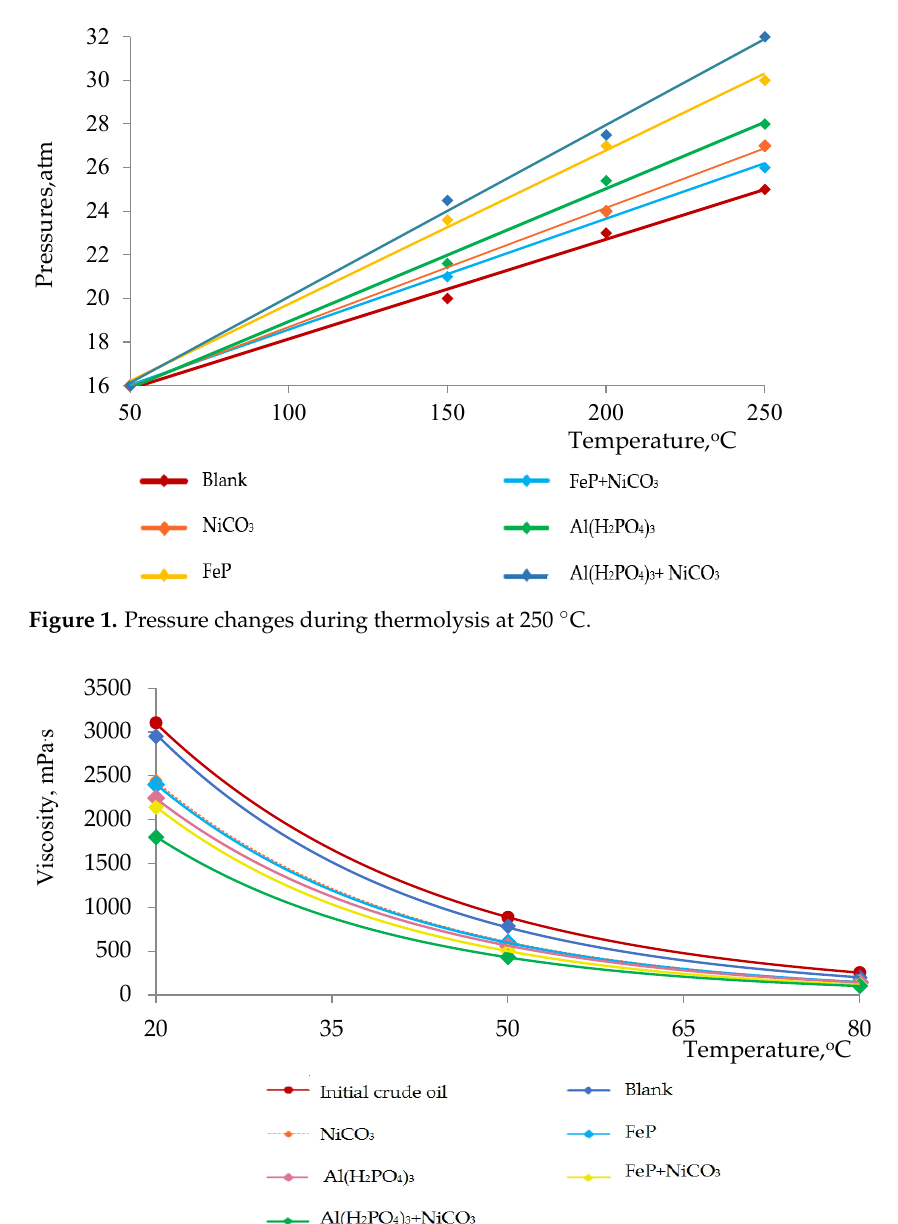
Figure 2. Dependence of viscosity on temperature in the process of thermolysis.